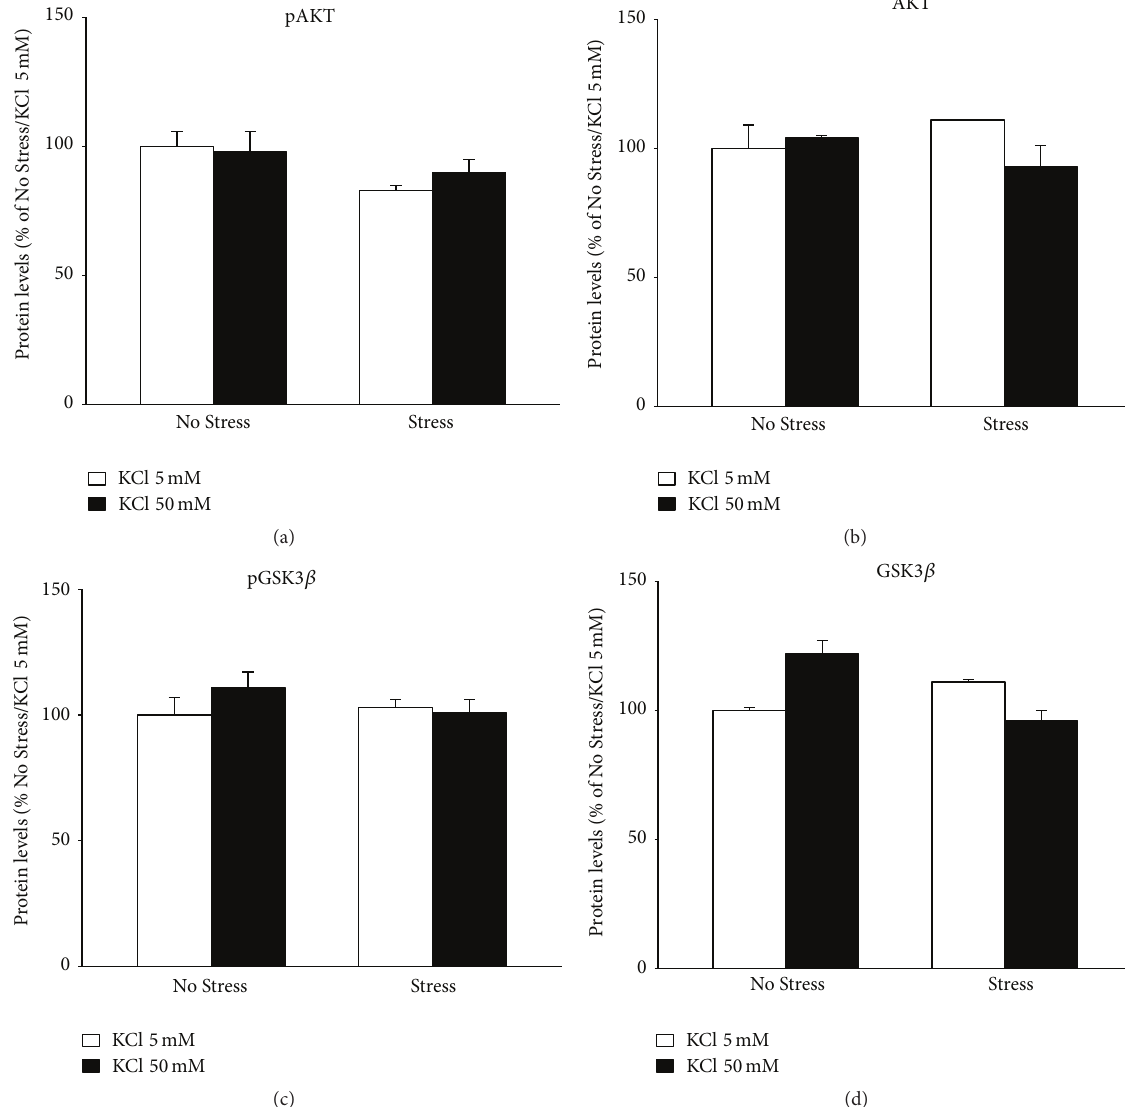
Figure 6: Protein analyses of BDNF mediated signaling: AKT and GSK3 𝛽 . The protein levels of the phosphorylated forms of AKT (a) and GSK3 𝛽 (c) and their total forms (b and d, resp.) were measured by Western blot analyses on protein extracts obtained from hippocampal slices obtained from unstressed (No Stress) or chronically stressed (Stress) rats exposed to KCl-induced depolarization (KCl 50 mM). The data, shown as a percentage referring to control group (No Stress/KCl 5 nM), are the mean ± SEM of independent determinations. Two-way